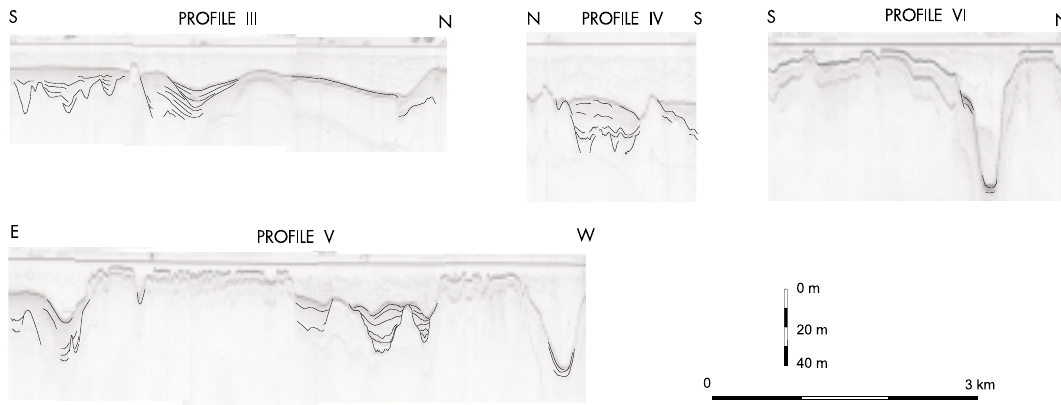
Fig. 9 – Seismic profiles 3, 4, 5, and 6, with internal reflectors and sea bed highlighted for